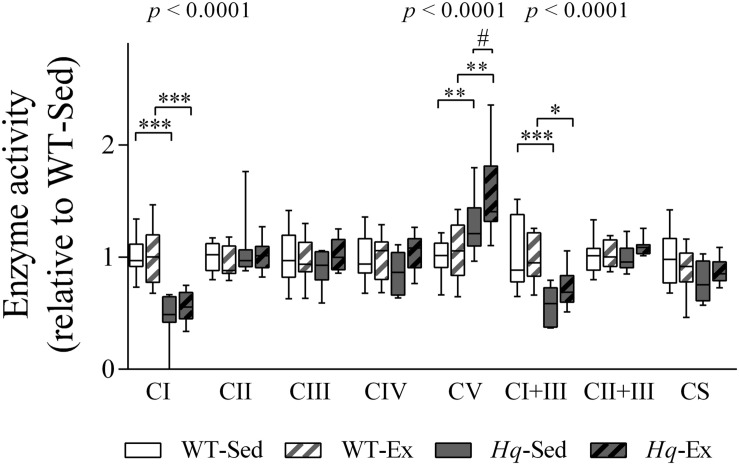
OXPHOS enzymatic activities in brain homogenates. Enzyme activities in total brain homogenates of wild-type sedentary (WT-Sed, n = 12), and exercise-trained (WT-Ex, n = 11) mice, and of Hq sedentary (Hq-Sed, n = 11) and exercise-trained (Hq-Ex, n = 10) mice. Data (median, interquartile range, and min and max values) are expressed relative to levels in the WT-Sed group. Significant p-values for the group effect (Kruskal-Wallis test) are shown above the corresponding boxes. Symbols for significant differences in post hoc pairwise comparisons: ∗p < 0.05; ∗∗p < 0.01; ∗∗∗p < 0.001 for Hq-Sed vs. WT-Sed, and Hq-Ex vs. WT-Ex; #p < 0.05 for Hq-Ex vs. Hq-Sed. Abbreviations: CI, II, III, IV, and V, respiratory complexes I, II, III, IV, and V; CI+III, activity of complex I coupled to complex III; CII+III, activity of complex II coupled to complex III; CS, citrate synthase.